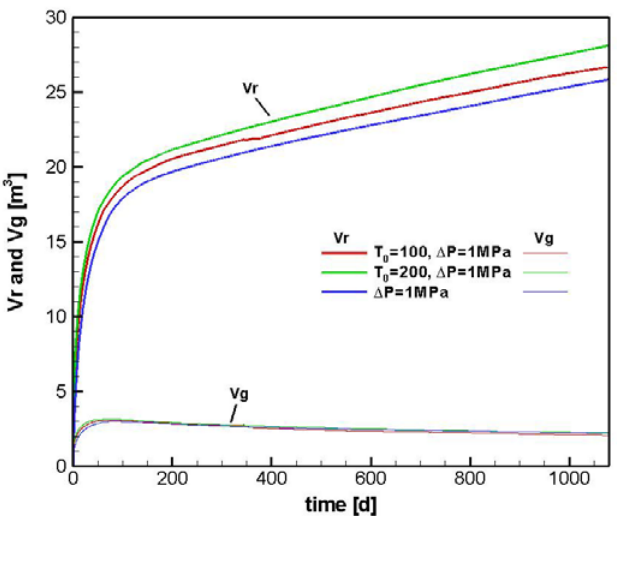
Figure 13. Cumulative volumes of released gas from hydrate deposit and gas remained in the reservoir. A 1-MPa depressurization is involved in the three